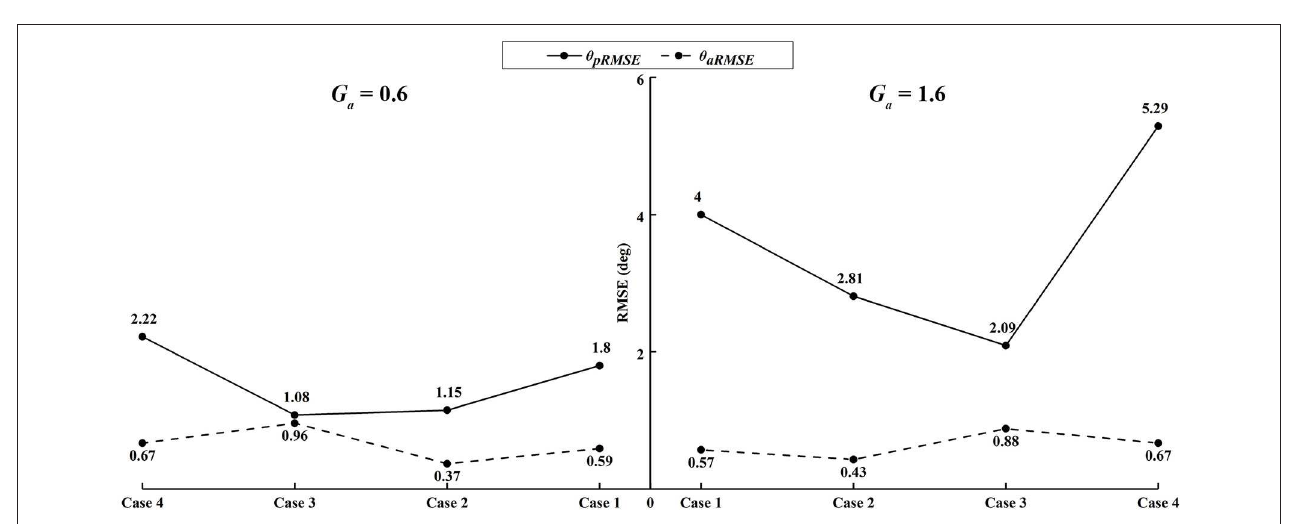
FIGURE 12 | The average RMSE of all participants in four active ankle movement cases.